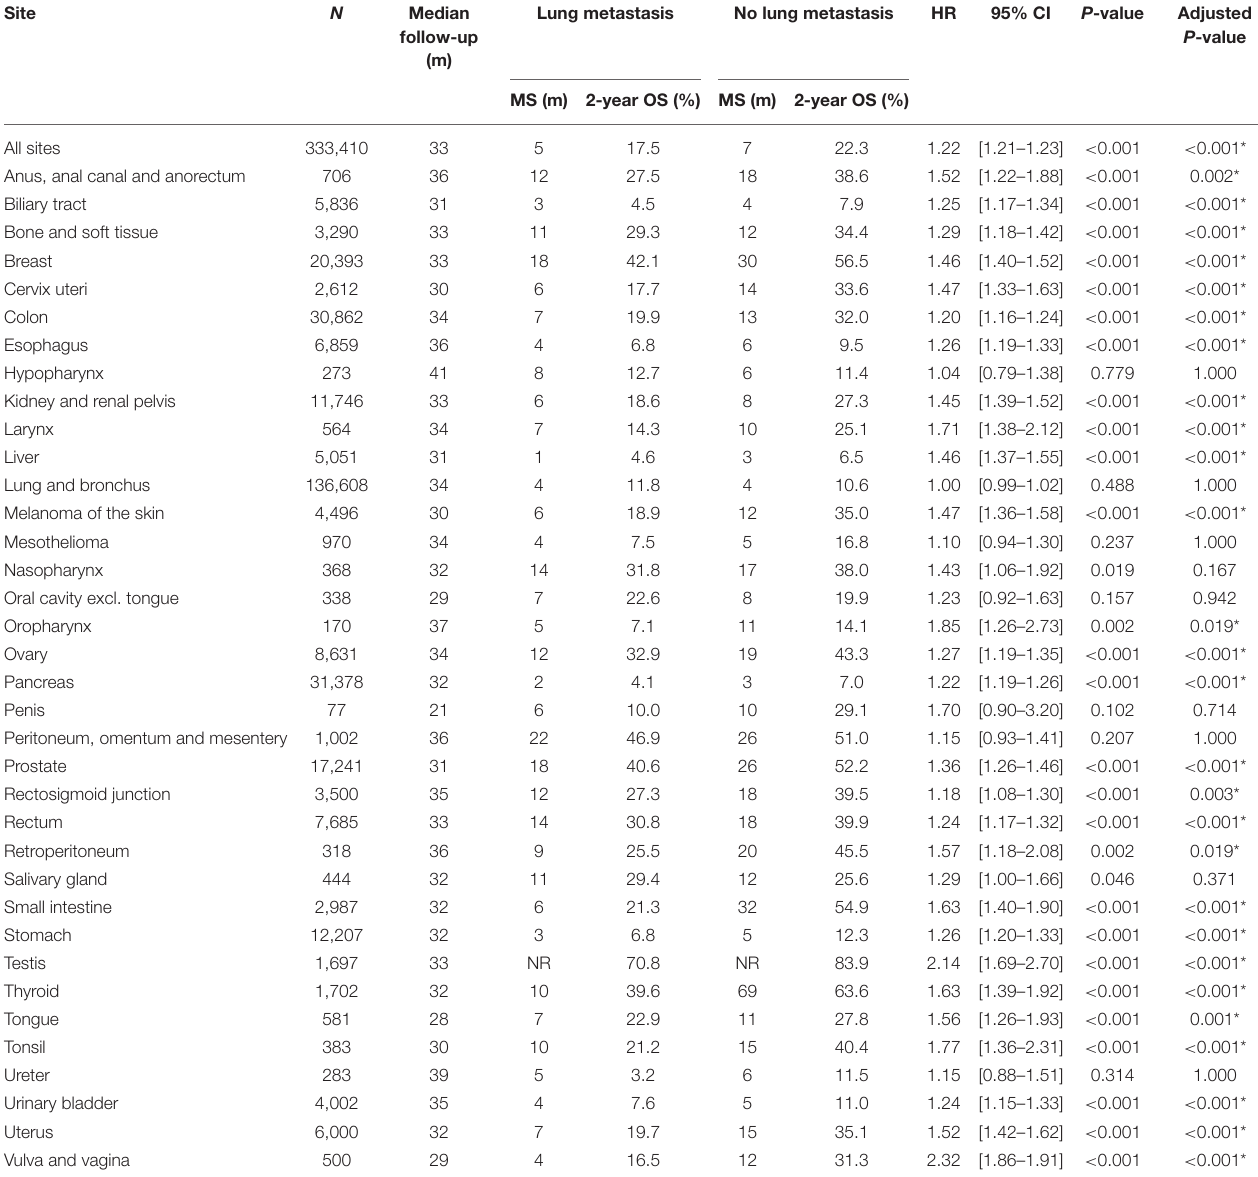
TABLE 4 | Sample size, median survival, 2-year survival and adjusted hazard ratios for death comparing de novo metastatic cases with and without lung metastasis, stratified by primary site of